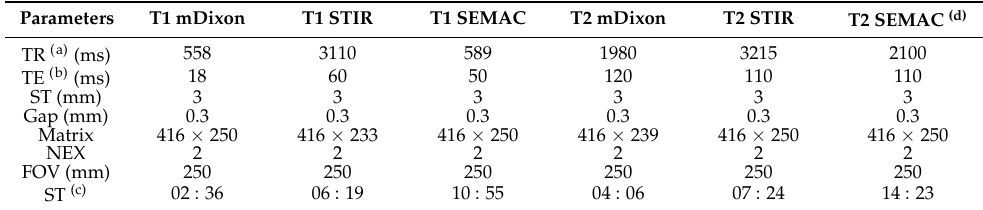
Table 2. T1, T2 Scan Parameters six kinds of MAR effect were applied to Phantom and patients.